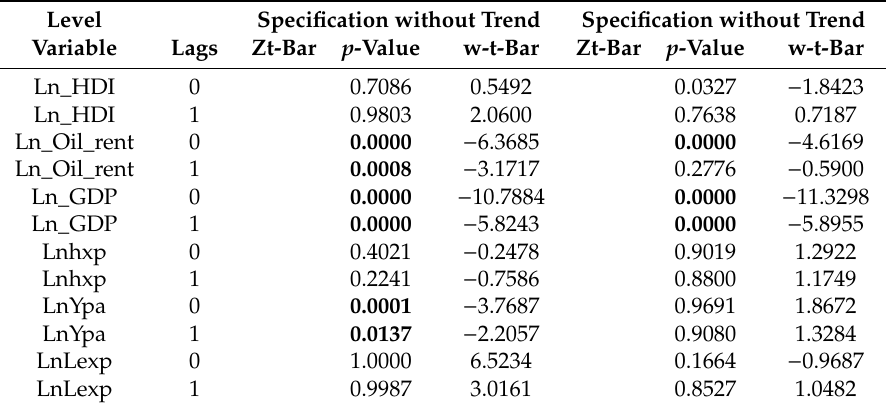
Table 10. Peseran, (2007) Panel Unit Roots test